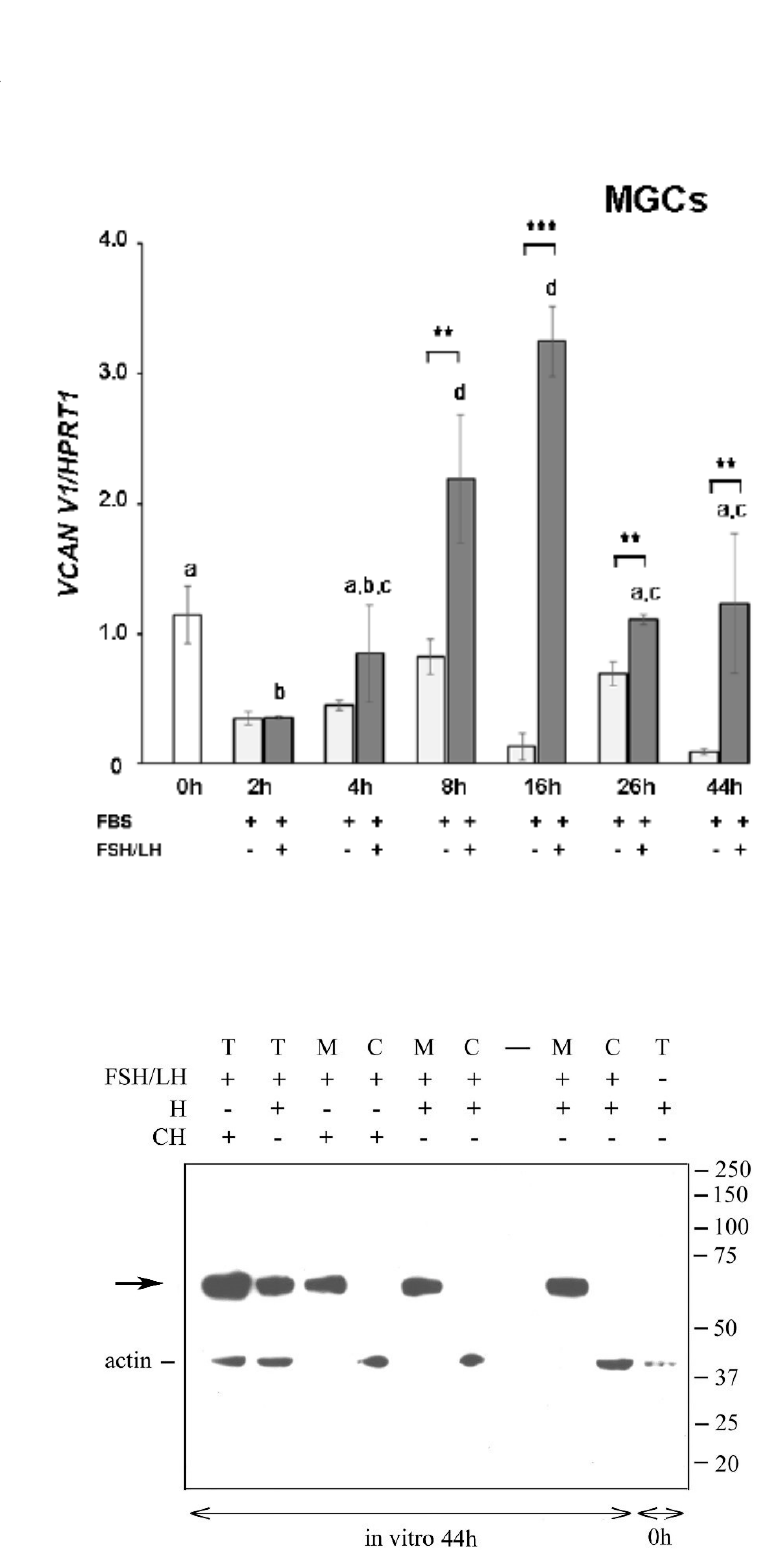
Figure 4. ( A ) Versican 1 mRNA ( VCAN V1 ) expression in hormone-stimulated mural granulosa cells (MGCs) cultured in vitro. Fifteen small pieces of follicle wall consisting of MGC aggregates were either immediately processed (0 h, white bar) or cultured in 5% FBS-supplemented medium without (light grey bars) or with (grey bars) FSH/LH for the indicated time points. The data shown are